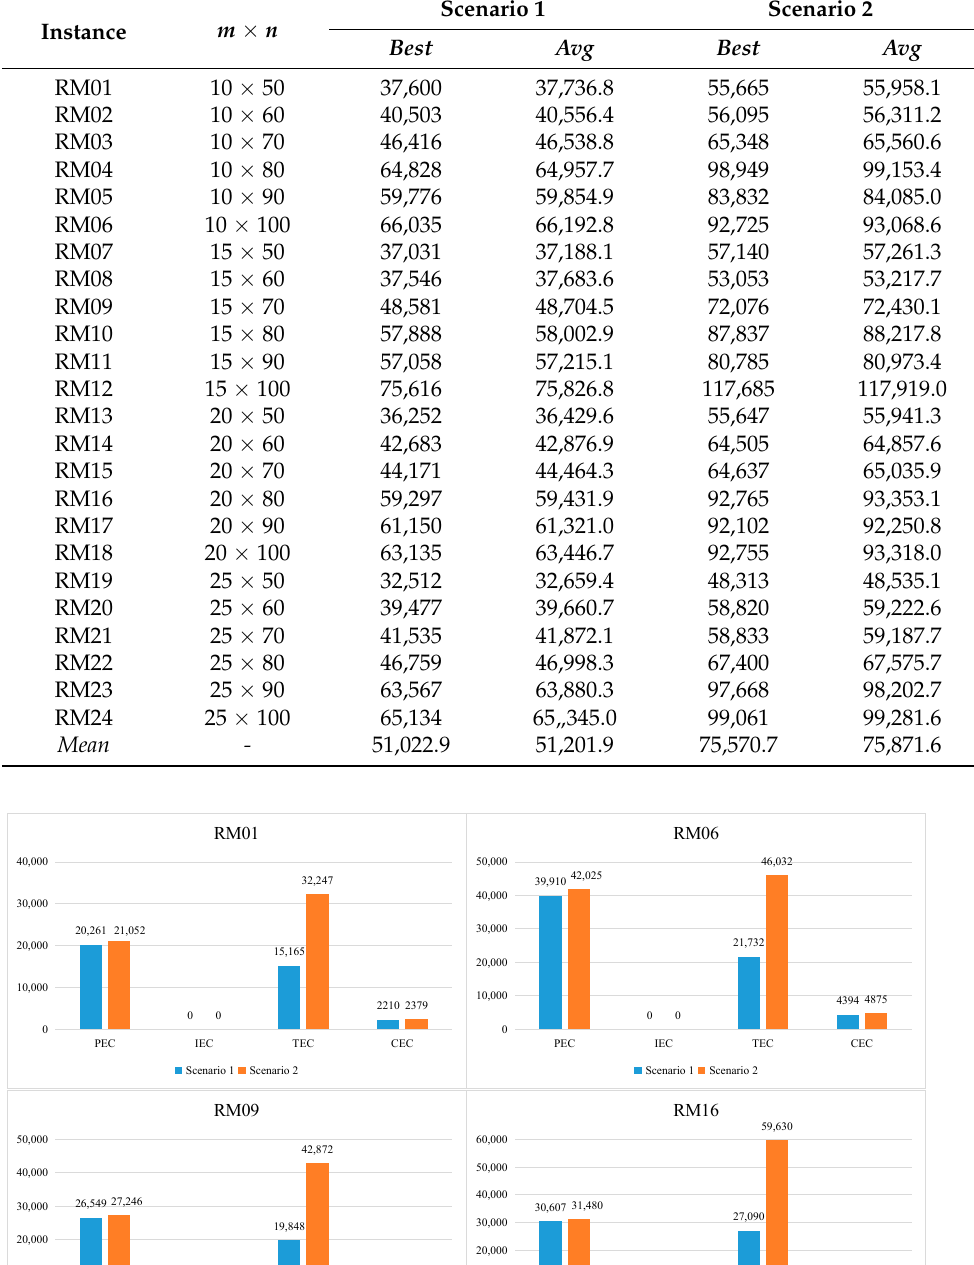
Table 9. Comparison results for two scenarios with different sublot number.